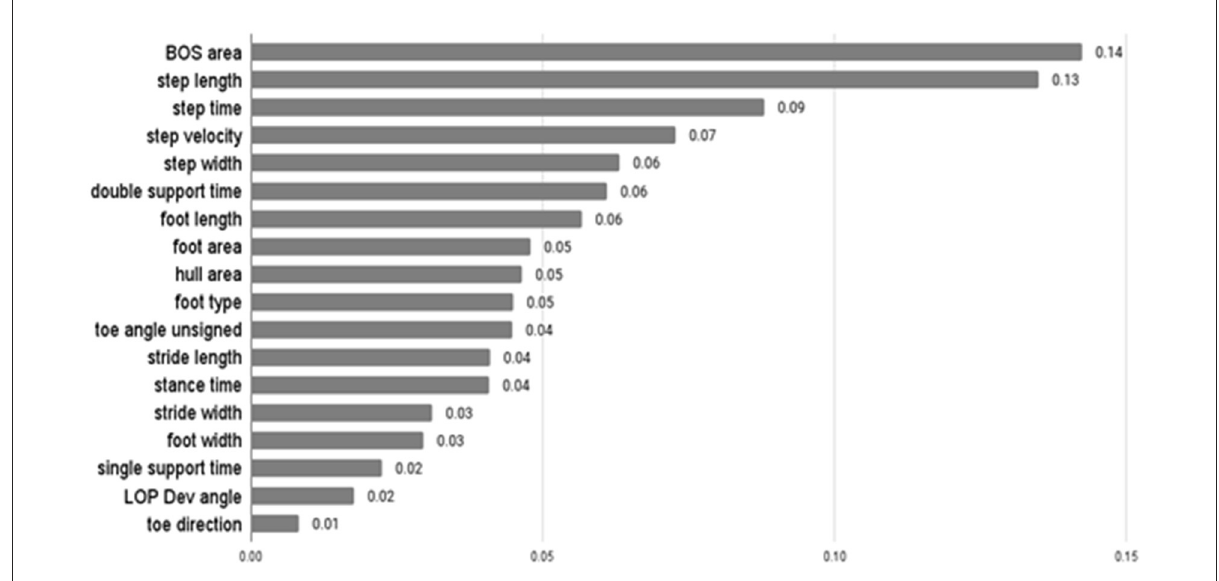
FIGURE4 Feature importance of XGB.